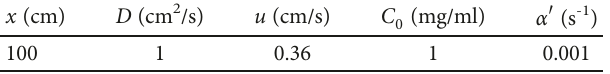
Figure 5: Relationship between particle concentration and time for four deposition rate coe ffi cients, using parameters given in Table 4. Table 4: Model parameters for simulations shown in Figure 5.